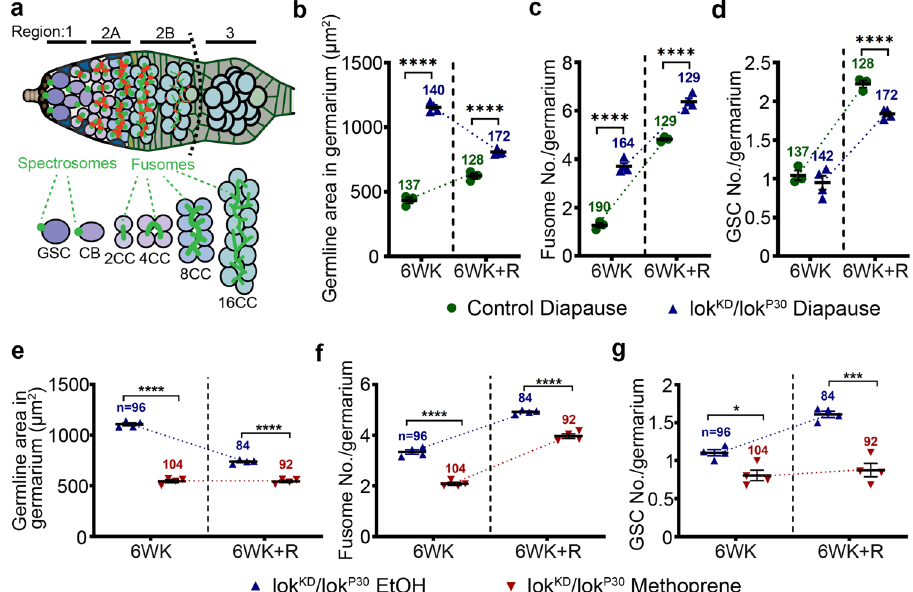
Fig. 5 Chk2 DNA damage checkpoint maintains GSC diapause arrest. a Schematic of a germarium showing regions 1 – 3 and spectrosome/fusome morphology (GSC germline stem cell, CB cystoblast, CC cyst cell). Dotted line shows region 2/3 border. b – d Quanti fi cation of germline area in regions 1 and 2 ( b ), fusome number ( c ), and GSC number ( d ) in germaria from control and lok KD/ lok P30 . The control for b – d is Canton S. e – g Quanti fi cation of germline area in regions 1 and 2 ( e ), fusome number ( f ), and GSC number ( g ) in the germarium from lok KD /lokP 30 treated with either ethanol vehicle (EtOH) or methoprene. Throughout Fig. 5, n = number of germaria analyzed. Data are mean ± s.e.m. from at least three independent experiments. Statistical analysis was carried out by unpaired two-tailed t test (* p = 0.0101; *** p = 0.0003; **** p < 0.0001). See also Supplementary Fig.